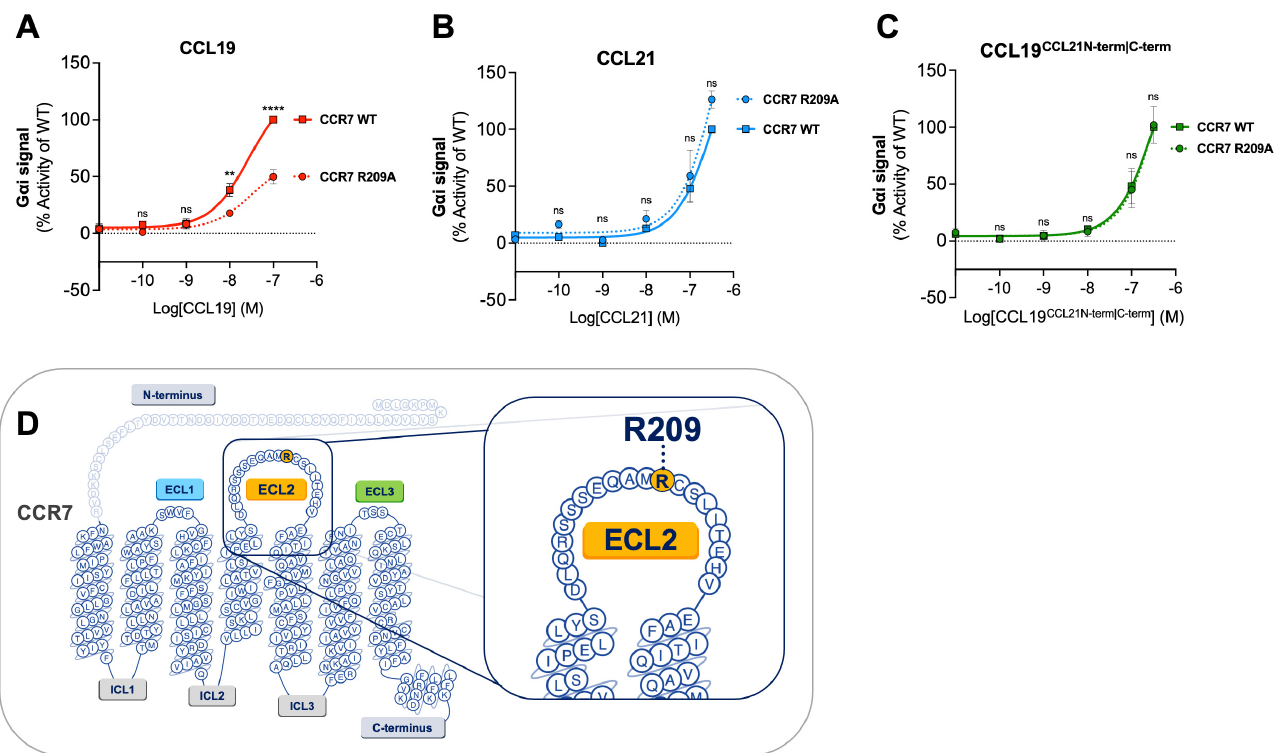
Figure 2. Alanine mutation of R209 in CCR7 does not affect CCL19 CCL21N-term|C-term potency in G α i signaling. Dose–response curves of CCR7 WT and CCR7 R209A stimulated with ( A ) CCL19, ( B ) CCL21, and ( C ) CCL19 CCL21N-term|C-term in a cAMP accumulation assay. Each set of data has been normalized to the WT dose–response curve within each individual experiment before the collection of data. Significant differences between CCR7 WT and CCR7 R209A have been analyzed using two-way ANOVA with Šídák’s multiple comparisons test. ** p < 0.01, **** p < 0.0001, ns not significant. Data are presented as mean values ± SEM (n = 3). ( D ) Serpentine structure of CCR7 displaying the location of residue R209 in the ECL2.